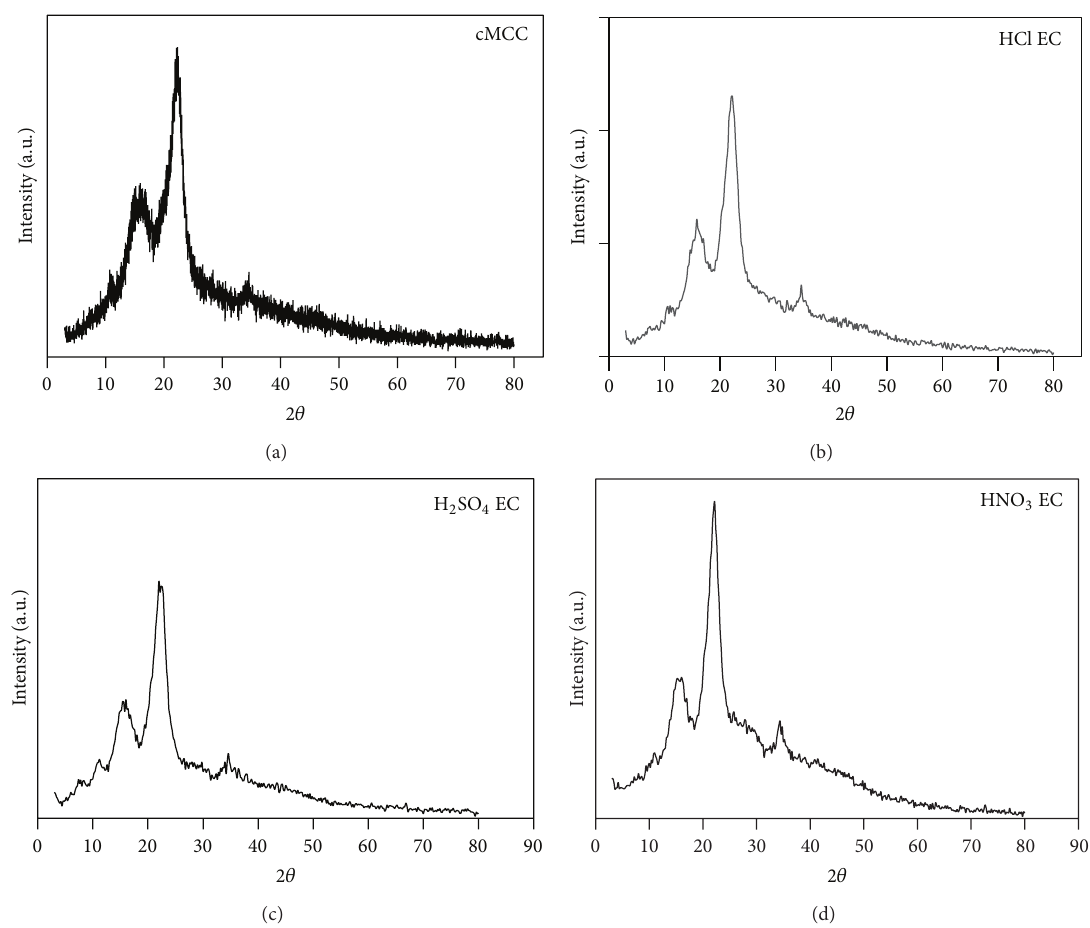
Figure 2: Showing the X-ray diffraction analyses of commercial cellulose (a) and acid hydrolyzed cellulose from wheat straw ((b)–(d)).